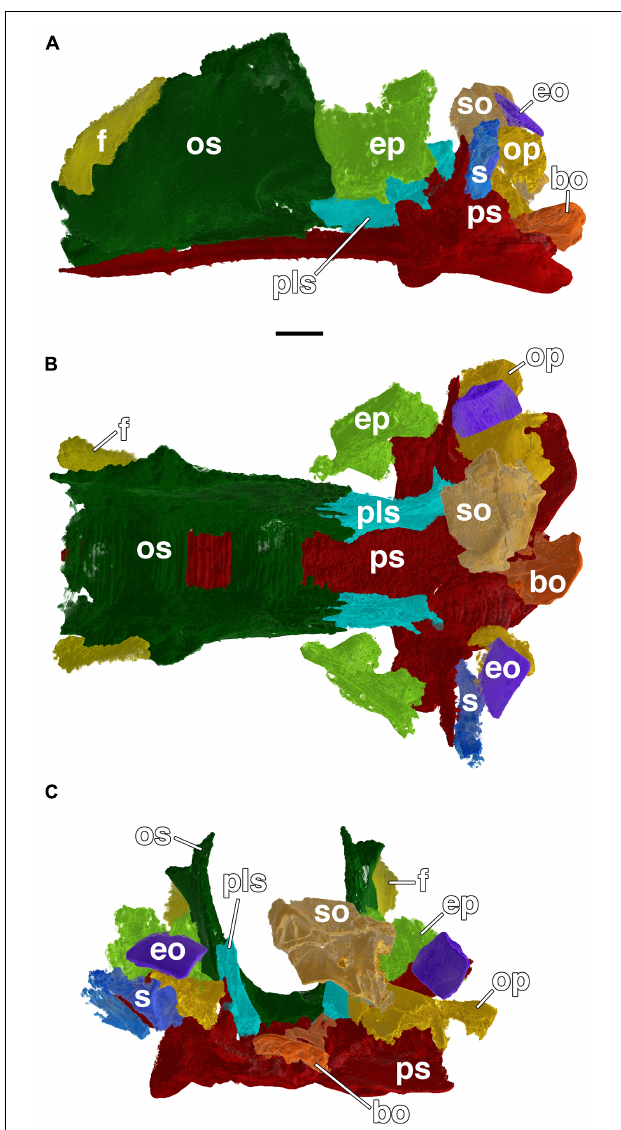
FIGURE 5 | Braincase elements preserved in Nannaroter mckinziei , OMNH 73107, reconstructed from CT data. (A) Left lateral view, (B) dorsal view, and (C) posterior view. bo, basioccipital; eo, exoccipital; ep, epipterygoid; f, frontal; op, opisthotic; pls, pleurosphenoid; ps, parasphenoid; so, supraoccipital; s, stapes. Scale bar equals 1